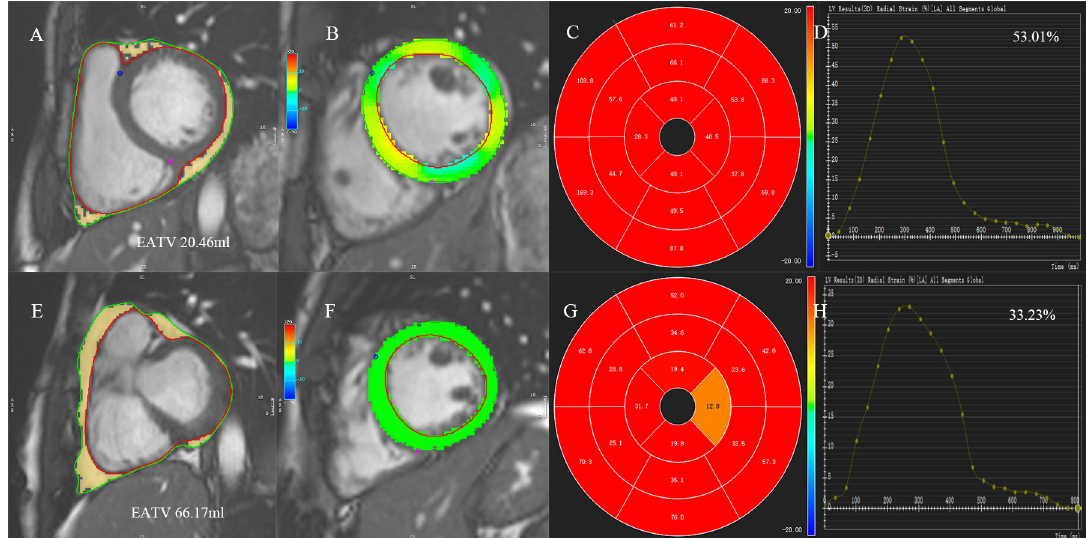
Fig 2. Examples of left ventricular global radial strain (LVGRS) and epicardial adipose tissue volumes (EATV) in 2 Amateur marathoners. A, E: the epicardial and pericardium boundaries were manually delineated at the short axis level of each atrium and the ventricle at the end of diastole, the yellow part between the red and green lines is the epicardial adipose tissue (EAT). B, F: color overlap map of short-axis view. C, G: 16-segment Bull’s eye maps with LVGRS results were displayed. D, F: strain analysis curves of LVGRS. Com-pared with the lower EATV (A), LVGRS was significantly more lower in the Amateur marathoner with larger EATV (E). LVGRS, left ventricular global radial strain; EATV, epicardial adipose tissue volumes; EAT, epicardial adipose tissue.